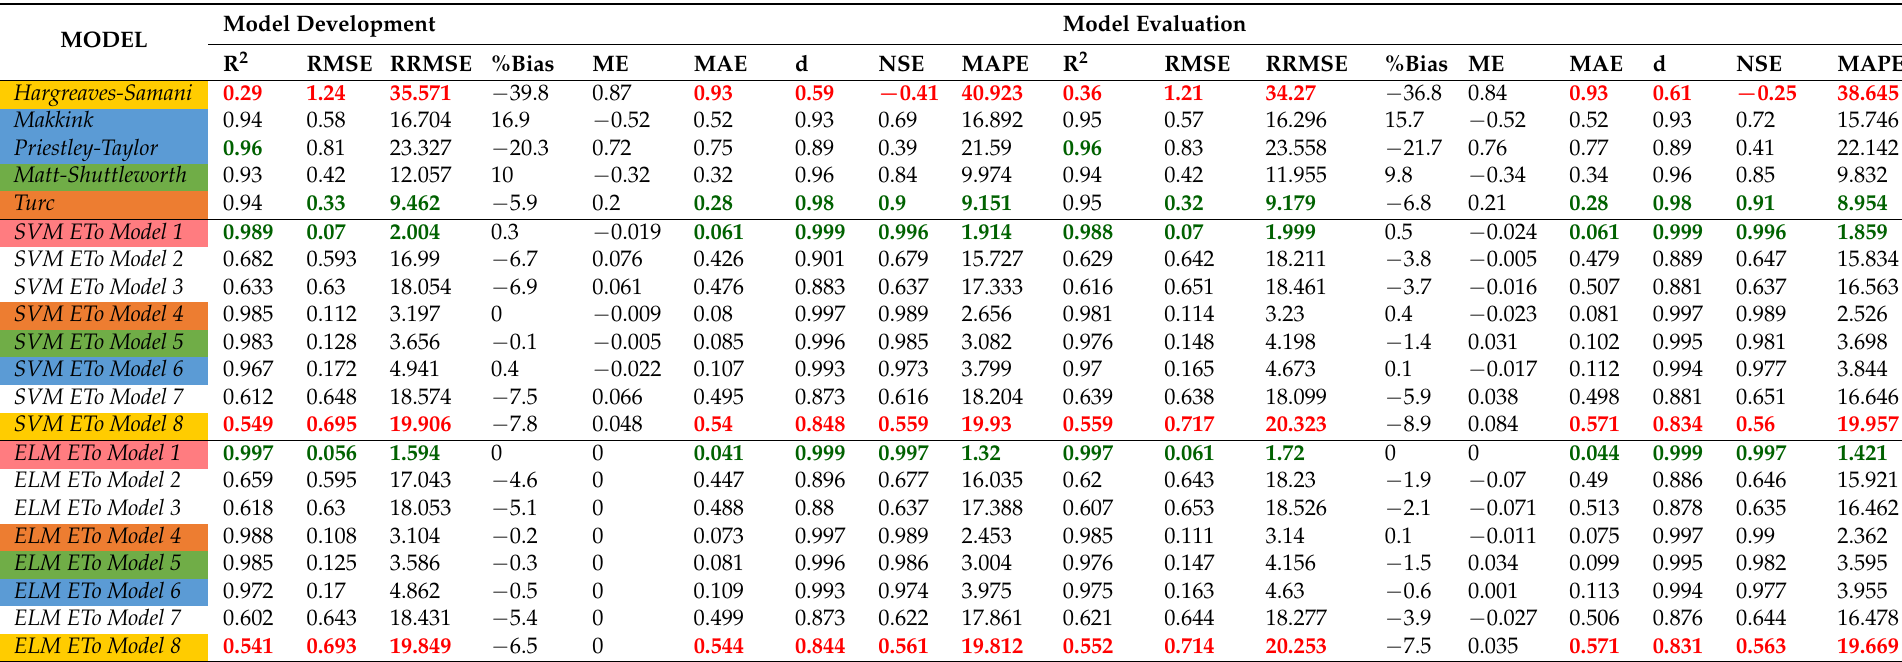
Table 7. Statistical values of empirical and machine learning models used for estimating daily ETo at Infanta Station